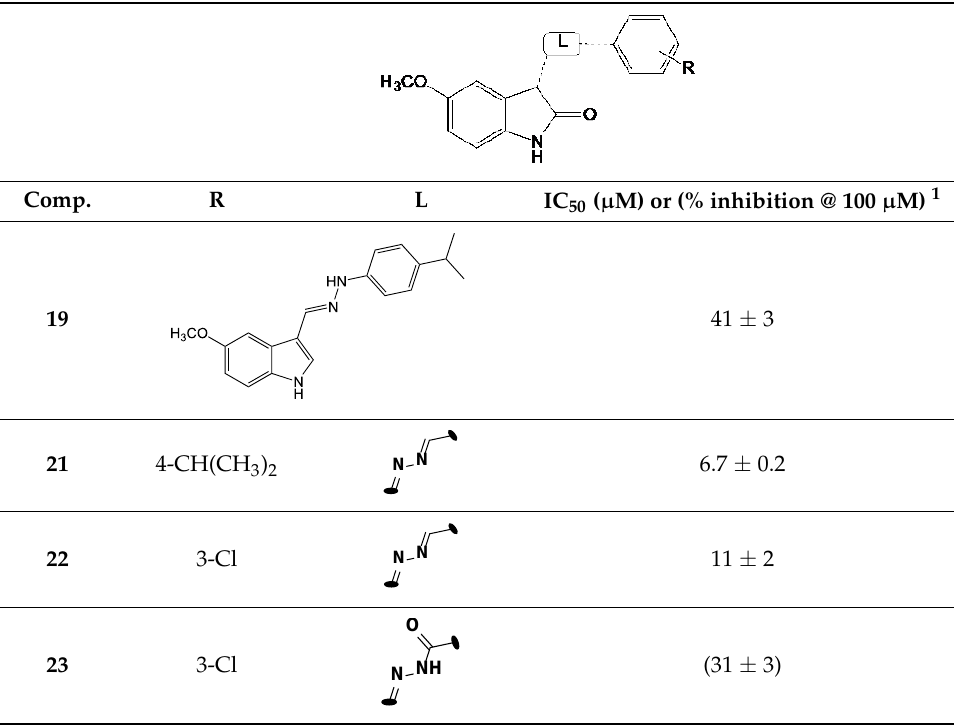
Table 3. A β Antiaggregating Activity of Compounds 19 and 21 – 23.